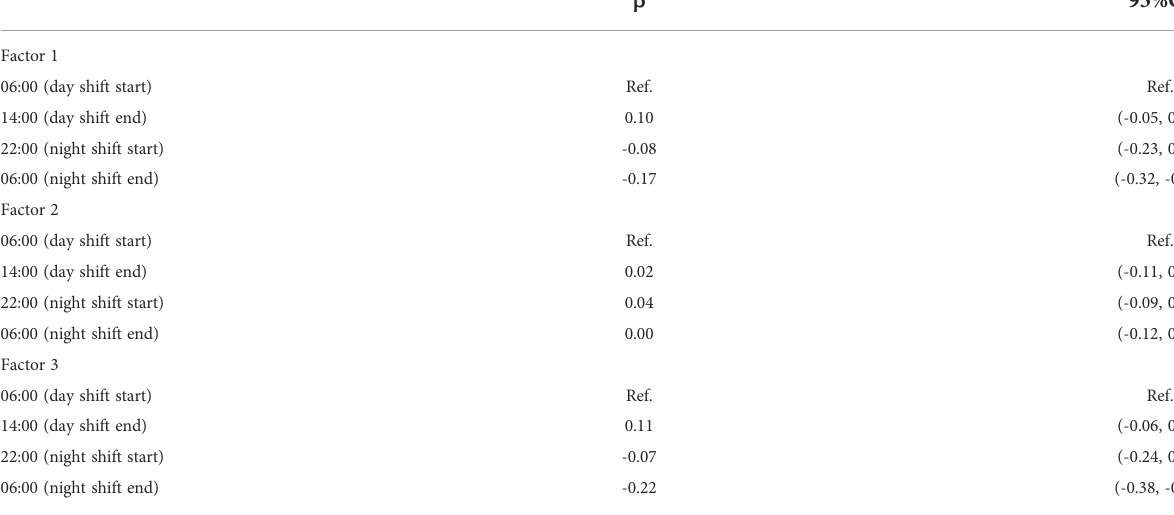
TABLE 4 Associations of the 3 factors, obtained through factor analysis, with shift work and time of